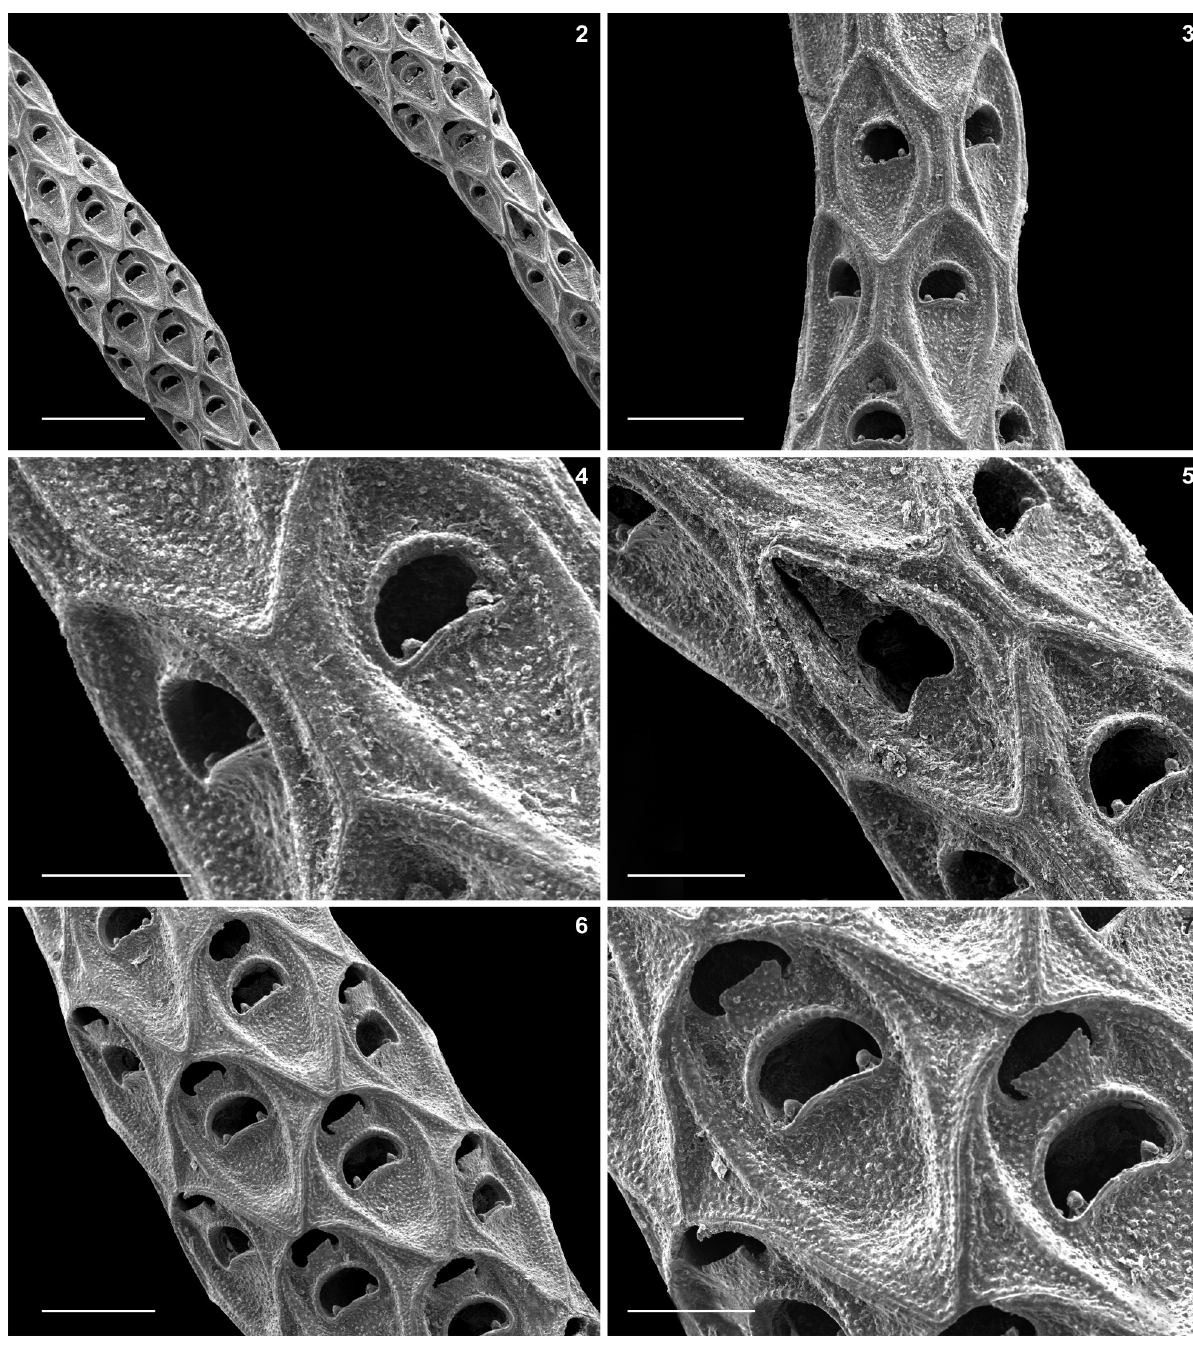
Figures 2–7. Cellaria oraneae sp. nov., UFBA 280, holotype, Bahia, Brazil: (2) general aspect of the branches; (3) close-up of subhexagonal autozooids; (4) close-up of opesia showing tuberculate distal rim and proximal condyles; (5) close-up of hexagonal interzooidal avicularia with longitudinal ridges forming a spear-shaped area and sagittate foramen; (6) close-up of fertile rhombic zooids; (7) close-up of immersed ovicells showing oval aperture with proximal rectangular lip. Scale bars: 2 = 500 µm; 3, 6 = 200 µm; 4, 5, 7 = 100 ZOOLOGIA 35: e24571 | DOI: 10.3897/zoologia.35.e24571 | March 9, 2018 3 /